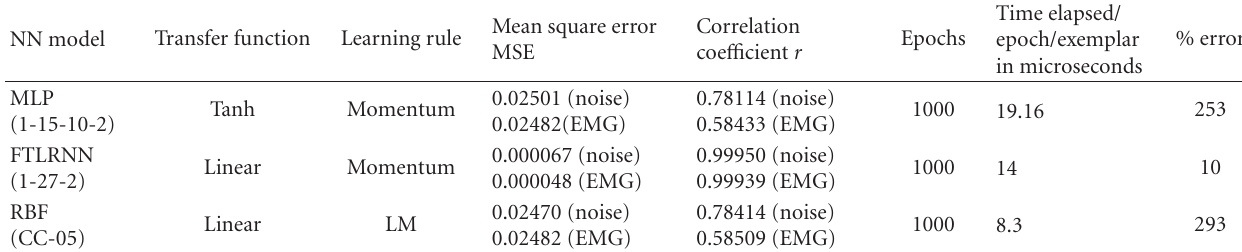
Table 16: Comparison of all the NN architectures on test